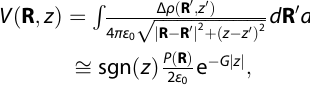
Figure 2e plot the spatial pro fi le of electrical polarization P ( R ), assuming the interface has a rigid twist from parallel, and the resultant electrostatic potential at three values of the vertical distance z / b . Taking b = 9.6 nm, which corresponding to twisting angle δ = 1.5°, these corresponds to the thickness of n = 2, 4, and 6 layers, respectively. The choice of twisting angle and the thickness of the top h-BN layer together allows the control of both the periodicity and the strength of the superlattice potential. At